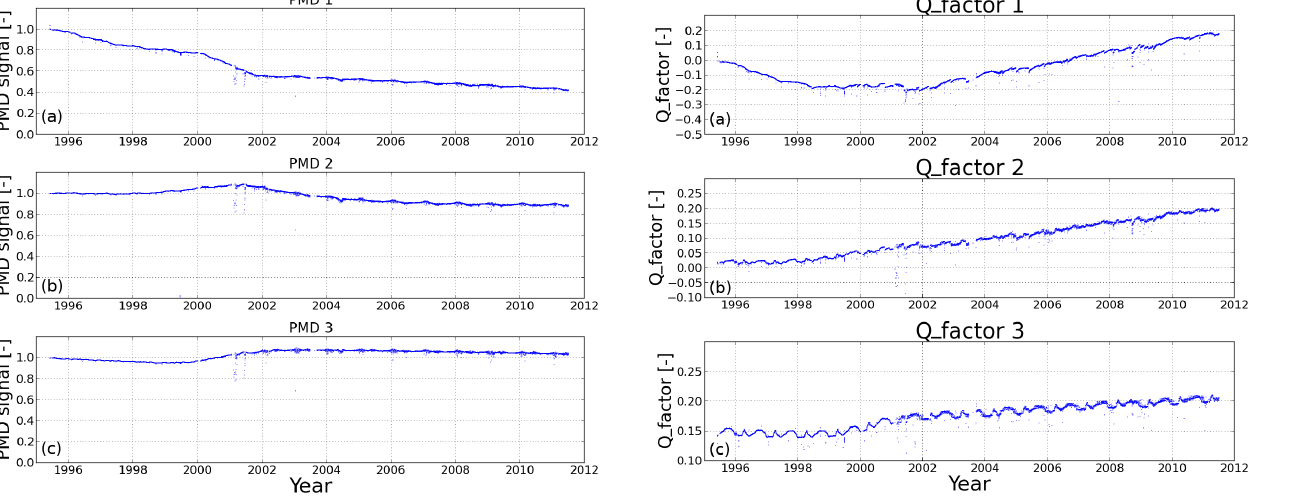
Figure 7. Q_factors 1, 2, and 3 (a–c) as a function of time from 1995 to